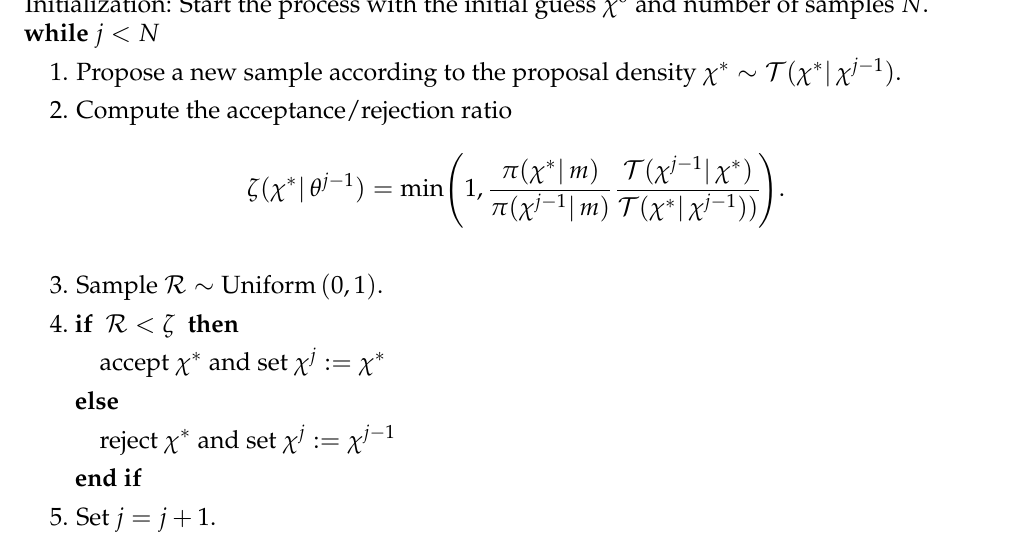
Algorithm 1 The Metropolis–Hastings